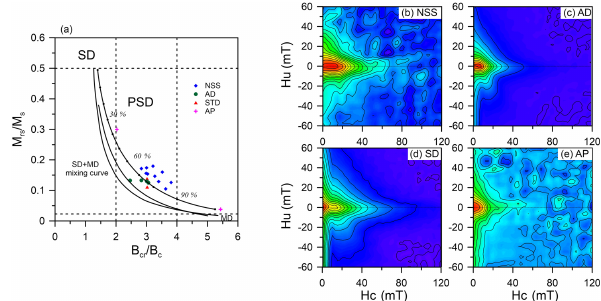
Figure 4. Day plot of the ratios M rs /M s vs. B cr /B c (a) and FORC diagrams (b–e) for representative samples from natural surface sediments (NSS), atmospheric dustfall (AD), street dust (STD), and anthropogenic pollutant (AP). Domain boundaries and the single-domain + multi-domain mixing line are according to Dun- lop (2002b). Percentages in the Day plot represent the concentra- tions of multi-domain in the single-domain + multi-domain